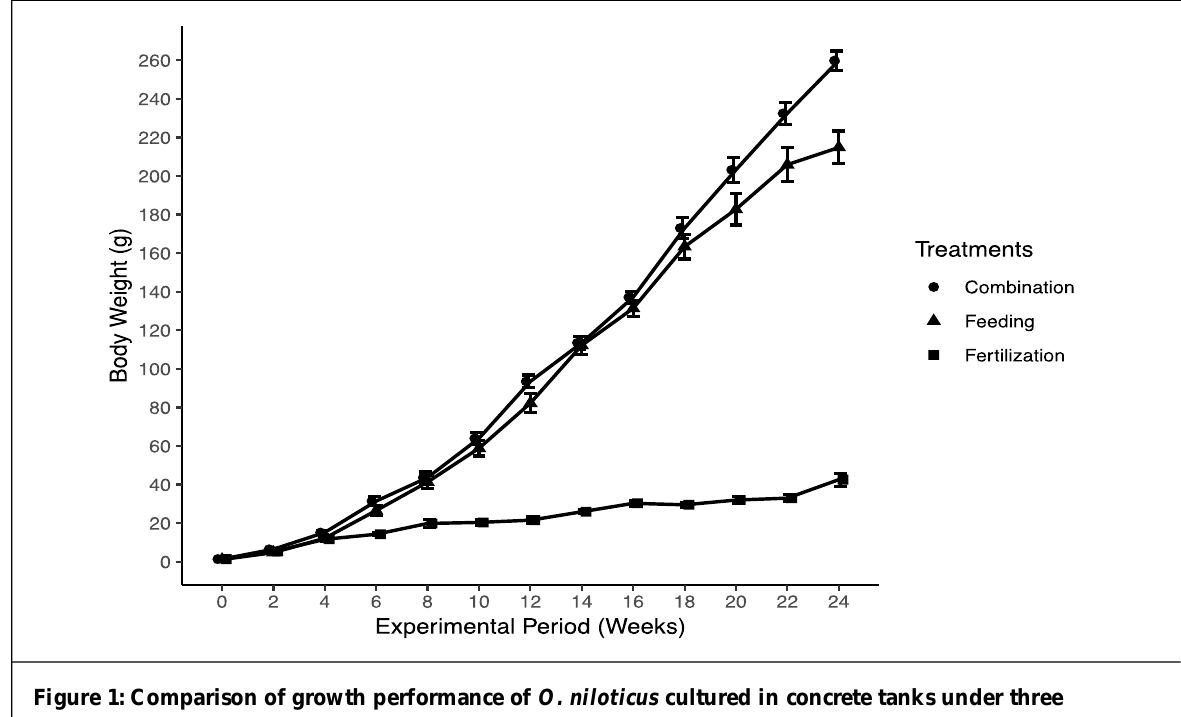
Figure 1: Comparison of growth performance of O. niloticus cultured in concrete tanks under three different treatments